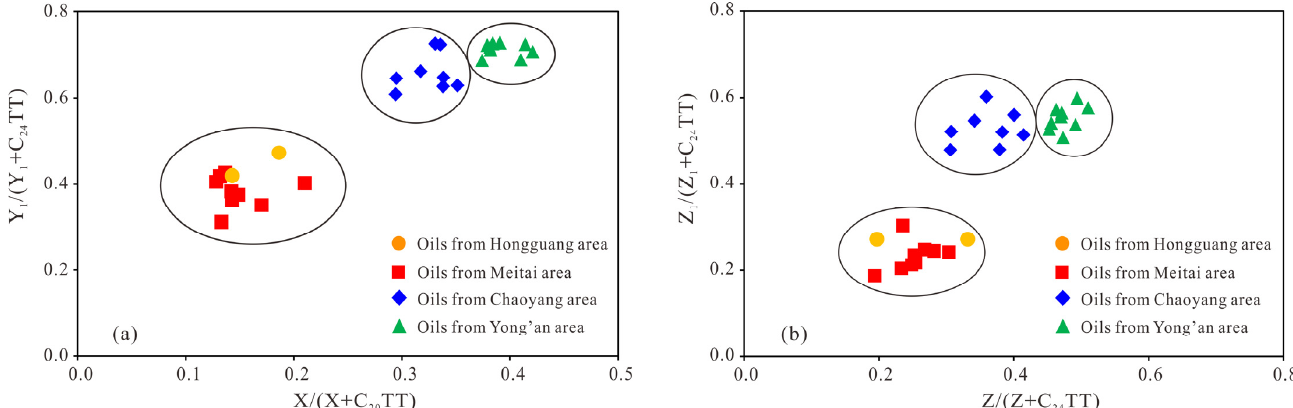
Figure 6. ( a ) A cross-plot of Y 1 /(Y 1 +C 24 TT) vs. X/(X+C 20 TT) for oils from Huangtong Sag. ( b ) A cross-plot of Z 1 /(Z 1 +C 24 TT) vs. Z/(Z+C 24 TT) for oils from Huangtong Sag. Note: X = C 21 tricyclic terpanes; Y 1 = C 25 tricyclic terpanes; Z = C 24 -des-A-ursane; Z 1 = C 27 tetracyclic terpane.